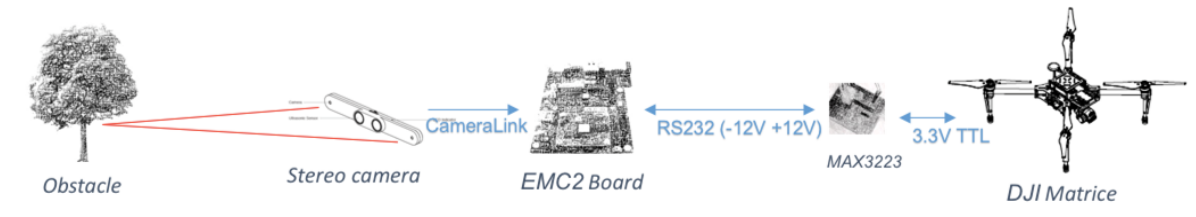
Figure 4. Illustration of the U-/V-map. The image on the left shows the reference image from the left camera of the stereo system. On the right the coloured disparity image is depicted, together with the U-map on top and the V-map on the right. The depths in the disparity image are colour coded, going from red (near) to blue (far). The white contour of the U-map represents the tree and its width (red). The V-map encodes ground plane (highlighted in pink) and the height of the tree (red). Furthermore the U-/V-map depict the computed waypoint.